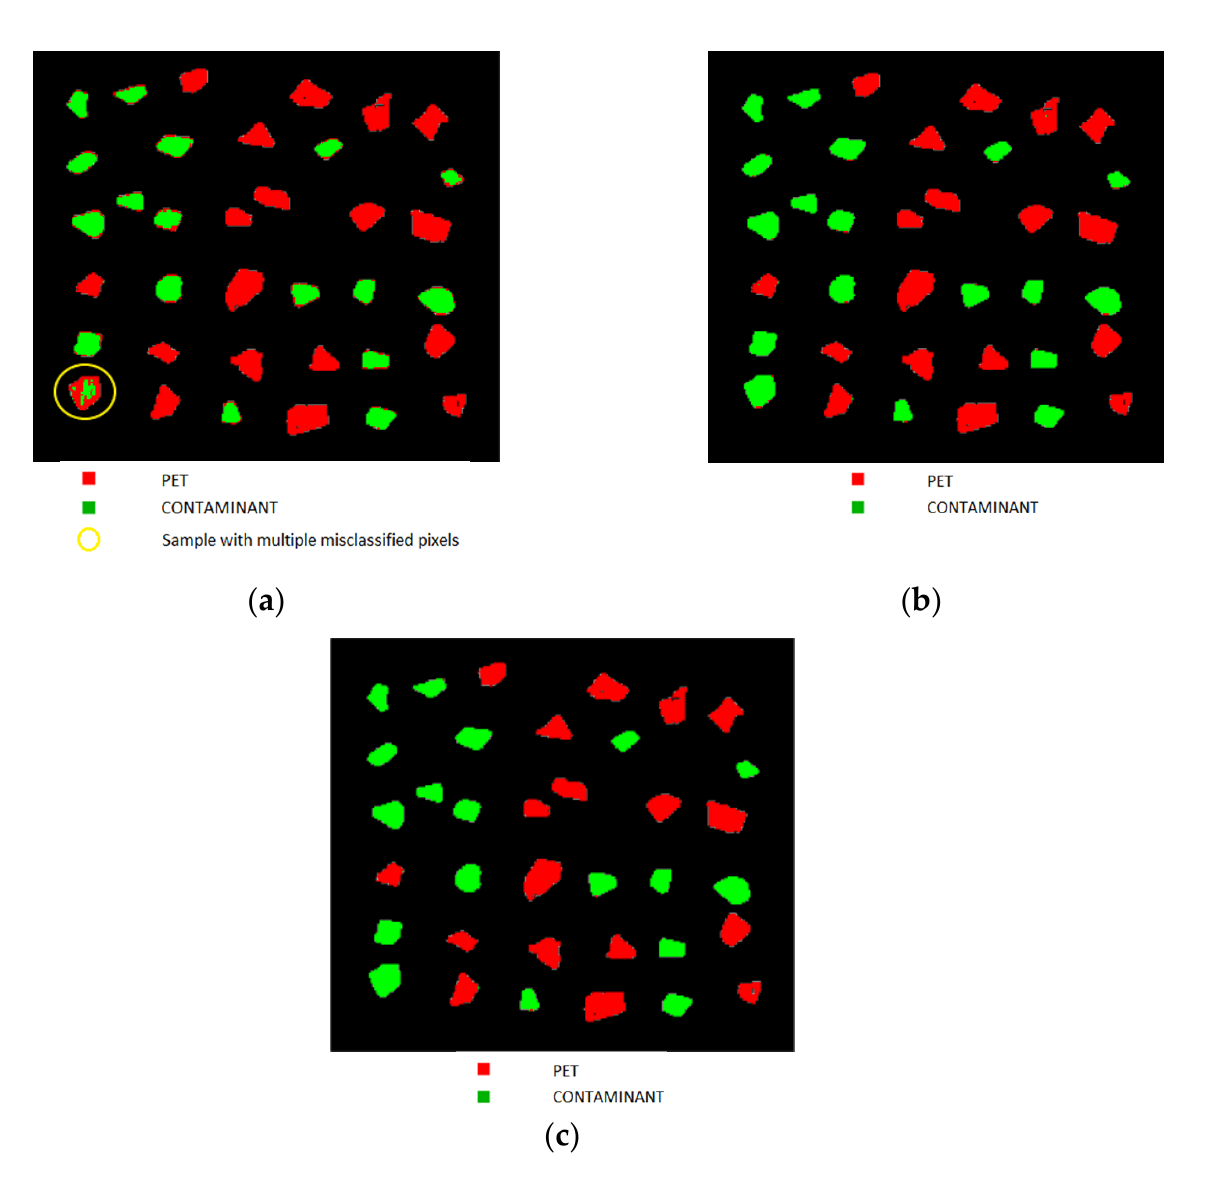
Figure 8. Prediction maps as resulting from the preliminary utilization of the 3 different preprocessing strategies (i.e., Set 1: Detrend + Smoothing + MC, Set 2: SNV + MC and Set 3: MSC + Derivative + MC) applied to the reduced set of wavelengths, resulting from CARS processing, and the further PLS-DA modeling. Prediction maps related to the utilized wavelengths as resulting from preprocessing Set 1: Detrend + Smoothing + MC ( a ), Set 2: SNV + MC ( b ) and Set 3: MSC + Derivative + MC ( c ). Table 4. PLS-DA classification performances in variables selection mode, for calibration (CAL), cross-validation (CV) and prediction (PRED) phases.